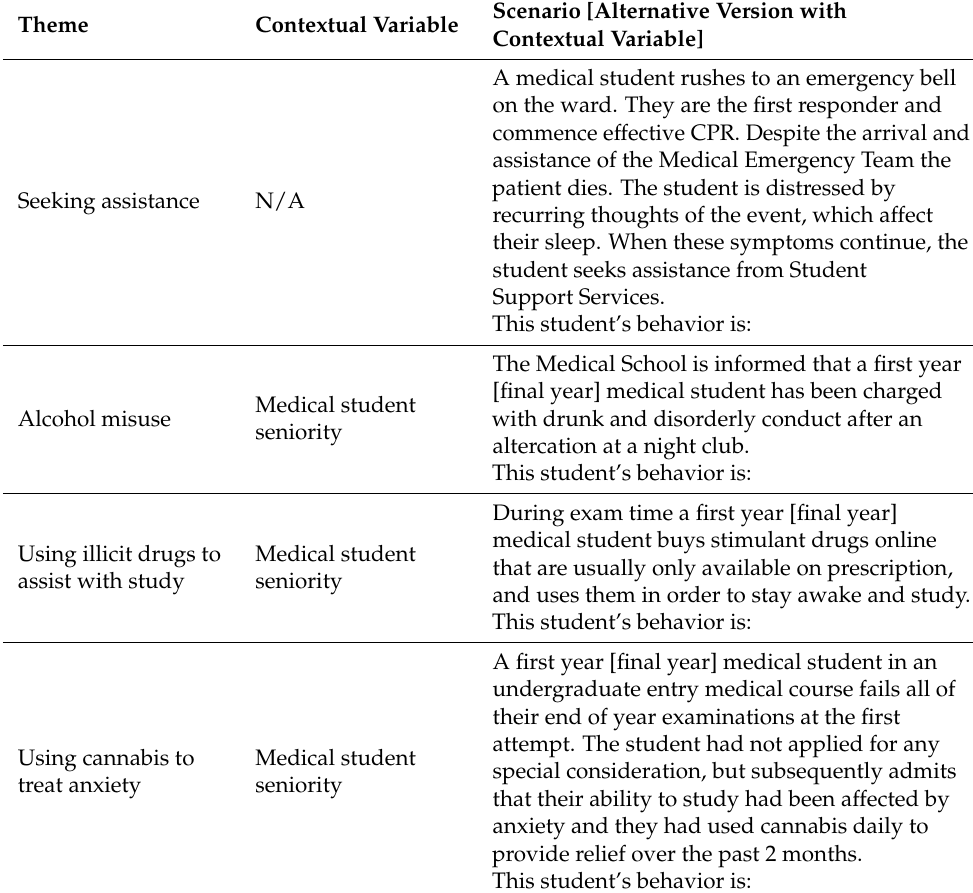
Table 1. PoMS Survey Scenarios Relating to a Self-care Theme with the Contextual